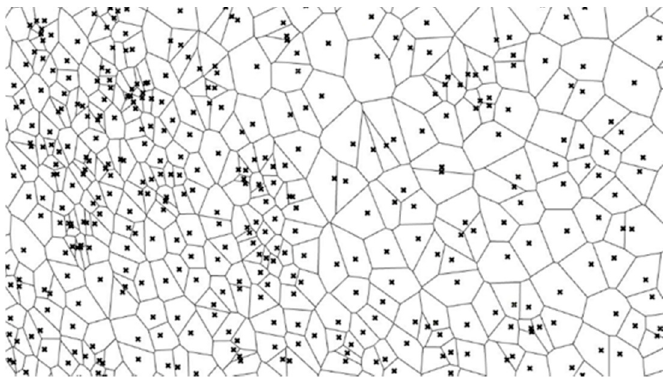
Figure 14. Voronoi division.